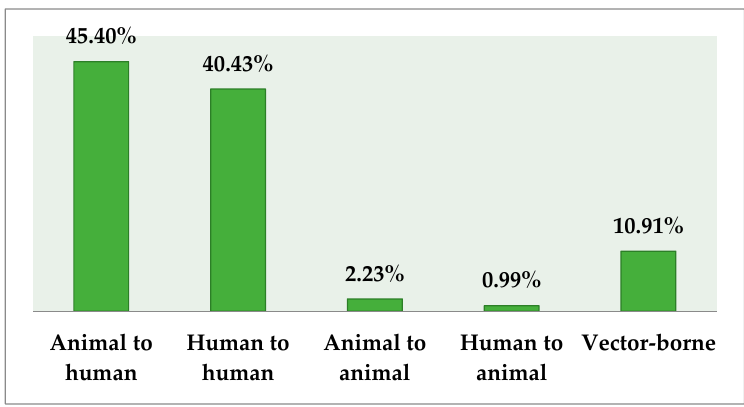
Figure 1. Respondents’ knowledge regarding route of transmission of Ebola virus disease (EVD) (%).